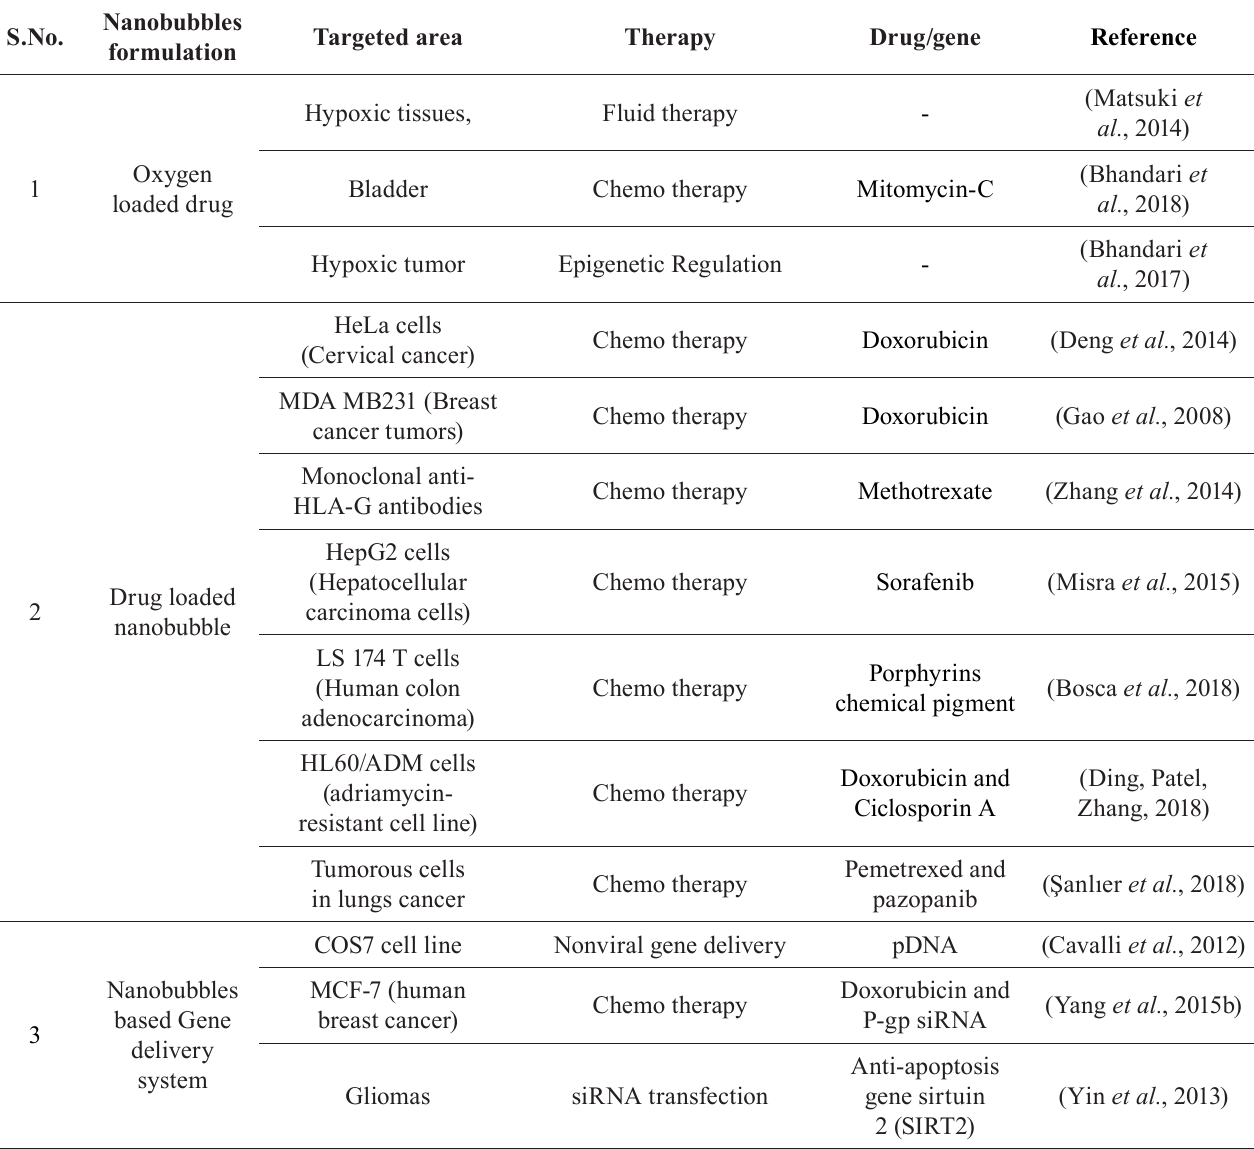
TABLE I - R ecent advances in nanobubbles formulation in the treatment of specific targeted tissues with the application of US energy